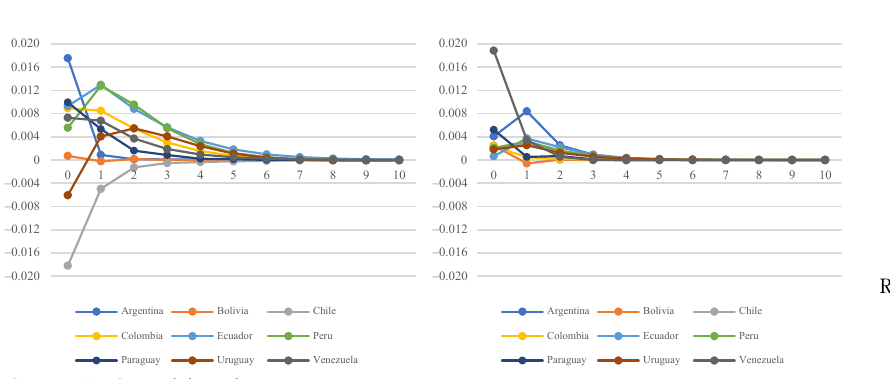
Figure 4. Response of